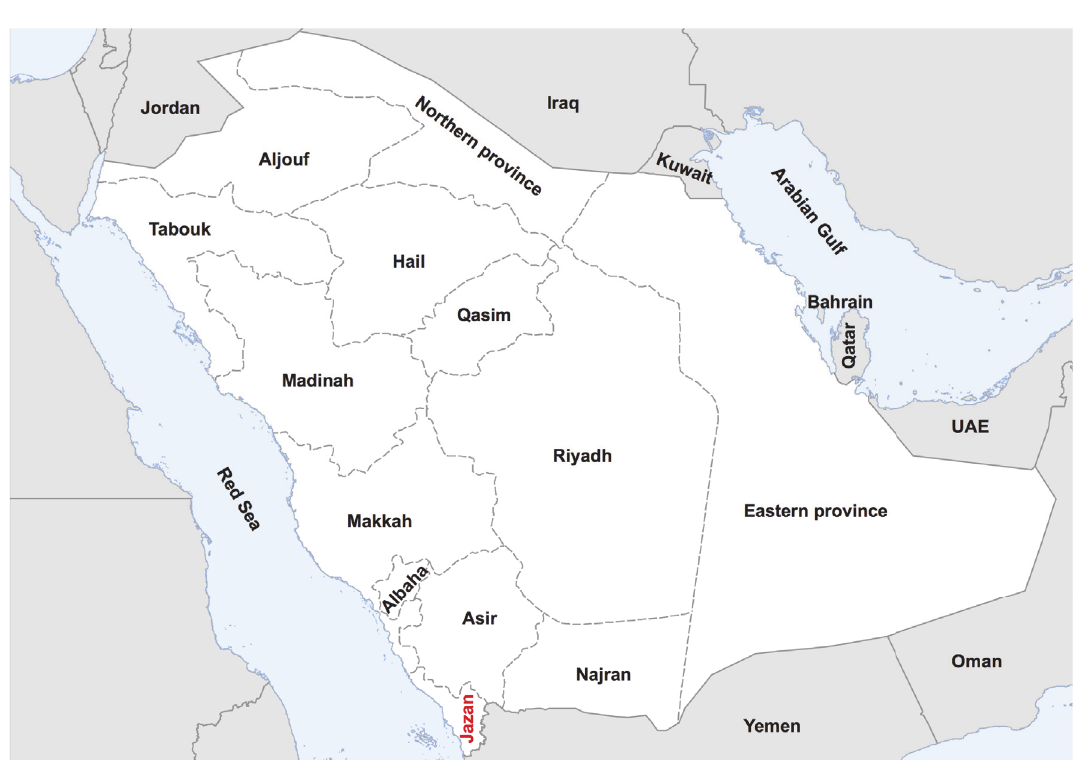
Figure 1: Map of Saudi Arabia showing the administrative provinces. Jazan province (red) is in the southwestern region of the country and north of